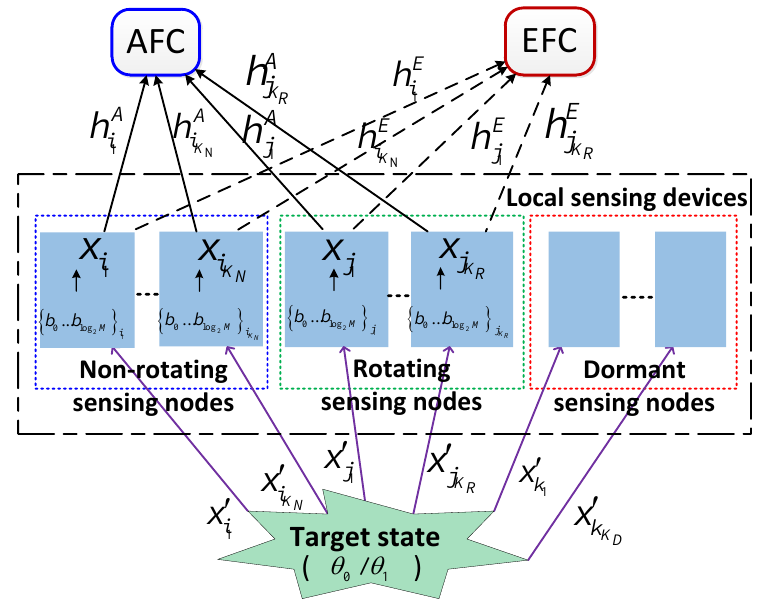
Figure 1. Distributed sensing system